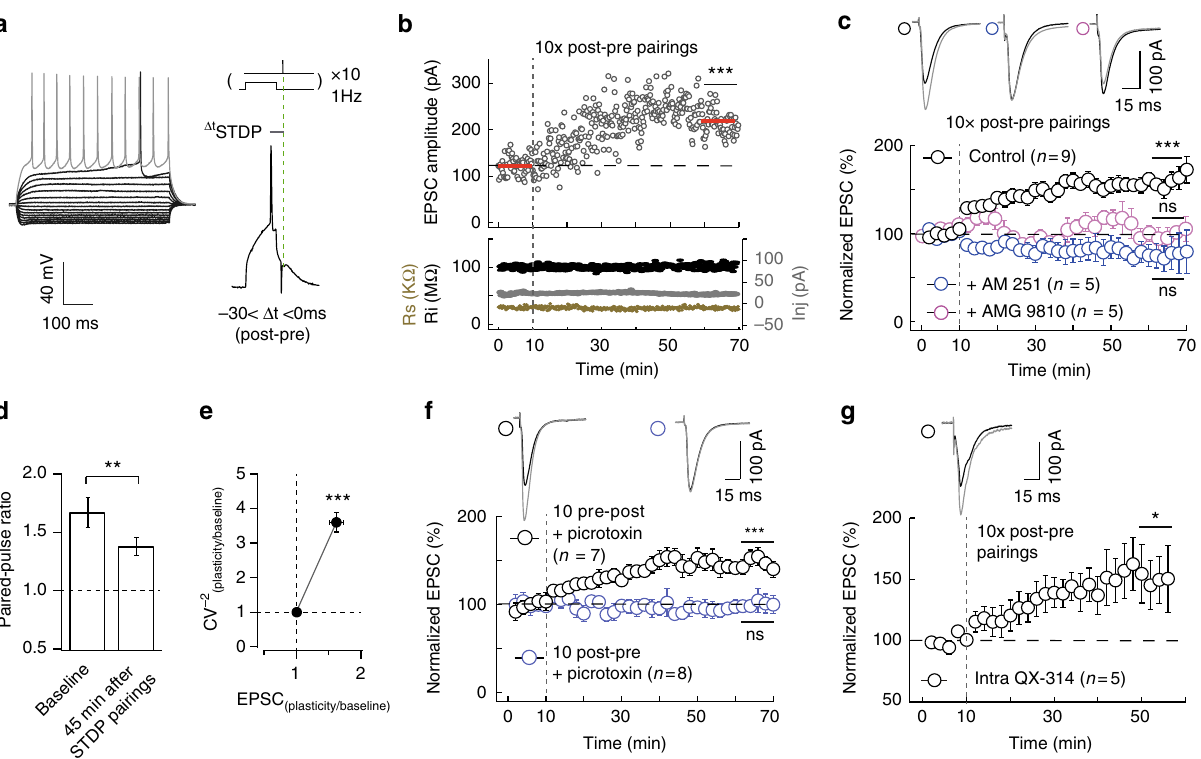
Fig. 1 eCB-tLTP is induced by low number of pairings. a Characteristic voltage responses of a MSN to a series of 500 ms current pulses from − 150 to + 180 pA with current steps increasing by 30 pA (black traces) and to + 60 pA above spike threshold (grey trace). STDP protocol: a spike-evoked in one MSN was paired with a cortical stimulation repeated 10 times at 1 Hz. Δ t STDP indicates the temporal time shift between pre- and postsynaptic stimulations. b , c 10 post-pre pairings induced tLTP CB 1 R- and TRPV1-activation dependent. b Example of tLTP induced by 10 post-pre pairings ( Δ t STDP = − 13 ms). Top, EPSC strength before and after 10 pairings (124 ± 4 pA and 203 ± 3 pA, p < 0.0001). Bottom, time courses of input resistance ( R i ) (before, 99 ± 1 M Ω ; after, 105 ± 1 M Ω ; change of 6%), access resistance ( R access ) (before, 30 ± 1 k Ω ; after, 29 ± 1 k Ω ; change of 3%) and injected current ( I inj ) (before, 24 ± 0.3 pA; after, 23 ± 0.2 pA). c Summary of STDP experiments showing that eCB-tLTP induced with 10 post-pre pairings ( n = 9, 9 cells out of 9 resulted in tLTP) is d Summary bar graphs ( n = 16 MSNs) of paired-pulse cortical stimulations (50 ms interstimulus interval) illustrate a decrease of facilitation after 10 post- pre pairings. This indicates a presynaptic locus of the eCB-tLTP. e Mean variance analysis (CV − 2 plasticity/baseline , n = 21) during baseline and 45 min after STDP pairings indicates a presynaptic locus of the eCB-tLTP. f With inhibition of ionotropic GABAergic transmission (picrotoxin 50 μ M), tLTP was observed with pre-post ( n = 7, 6/7 showed tLTP) but not with post-pre ( n = 8, 1/8 showed tLTP) pairings. GABA controls the time dependence but not the magnitude of eCB-tLTP. g Intracellular application of a Na + channel blocker, QX-314 (1 µ m, n = 5, 5/5 showed tLTP), did not prevent 10 post-pre pairings LTP. Representative traces are the average of 15 EPSCs during baseline (black traces) and 45 min after STDP protocol (grey traces). Vertical grey dashed line indicates the STDP protocol. Error bars represent sem. * p < 0.05; ** p < 0.01; *** p < 0.001; ns: not signi fi cant by t -test, two-tailed ( b ), one sample t